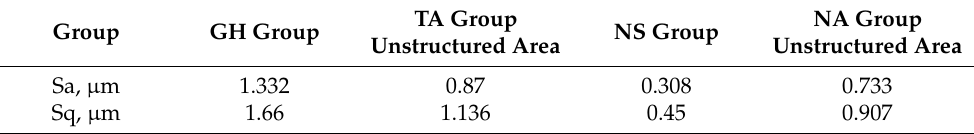
Table 4. Characterization of wear surface roughness under different treatments Sa and